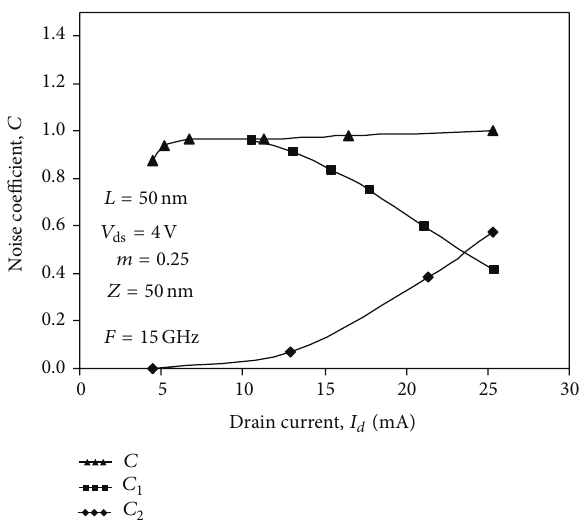
Figure 11: Dependence of noise correlation coefficient 𝐶 on drain current.